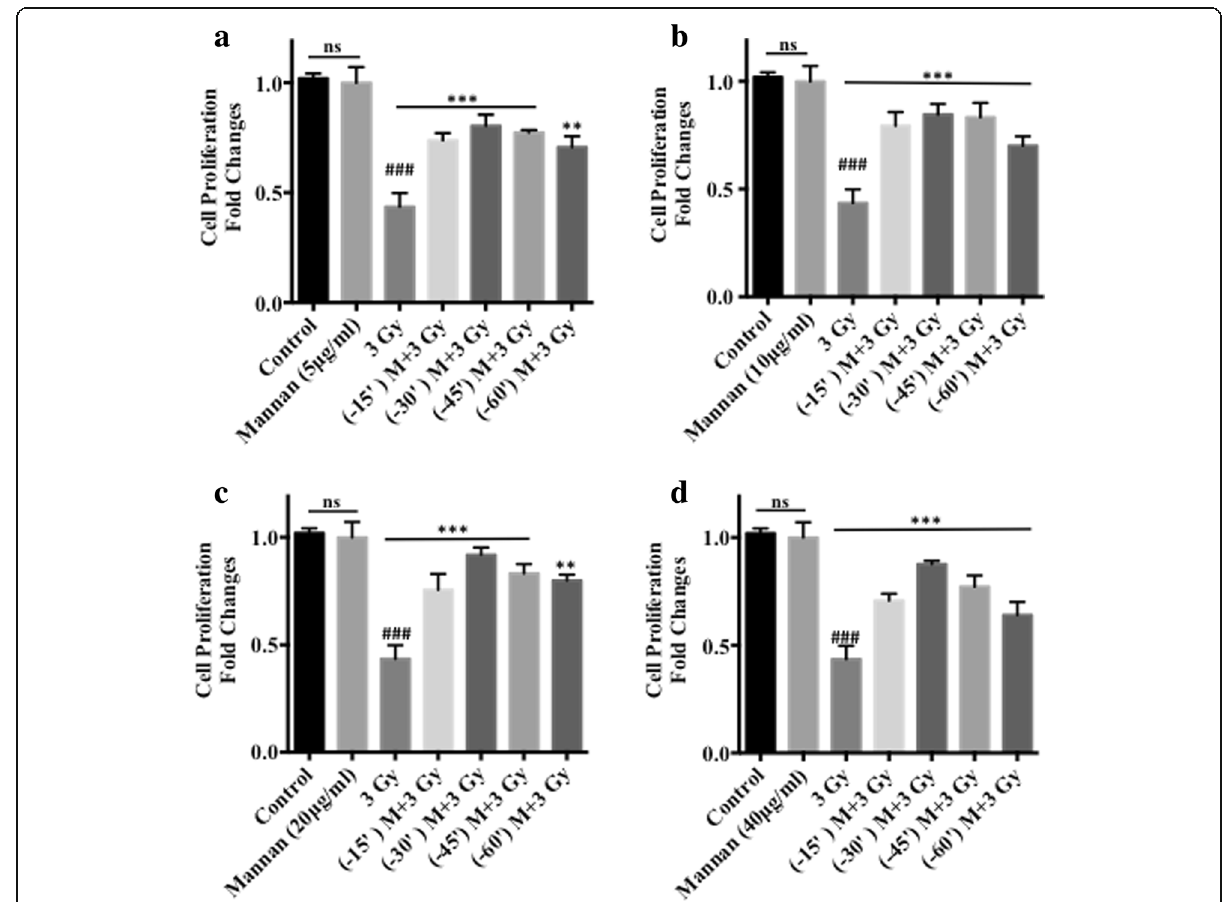
Fig. 3 Sulforhodamine B uptake Assay. Effects of pre-irradiation treatment of NKE cells with mannan [( a ) Mannan conc. 5 μ g/ml ( b ) Mannan conc. 10 μ g/ml ( c ) Mannan conc. 20 μ g/ml ( d ) Mannan conc. 40 μ g/ml] for different time intervals was measured in terms of cell proliferation (SRB uptake assay) 96 h post irradiation. Results are expressed as cell proliferation (fold changes) with respect to control ± SD of three independent experiments. Differences were designated significant at values ** p < 0.001 and *** p < 0.0001 and were labeled as # compared with the